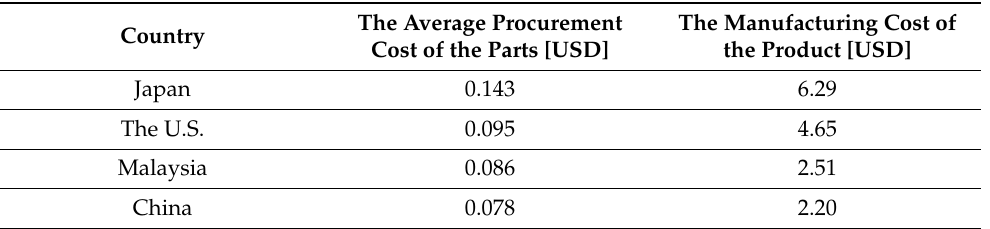
Table 2. The average procurement price of the parts and manufacturing cost of the product in each country